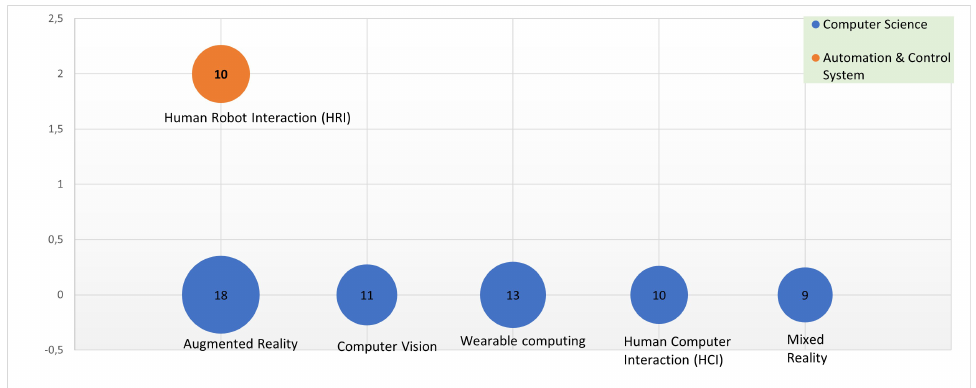
Figure 5. Number of keyword repetitions per area.